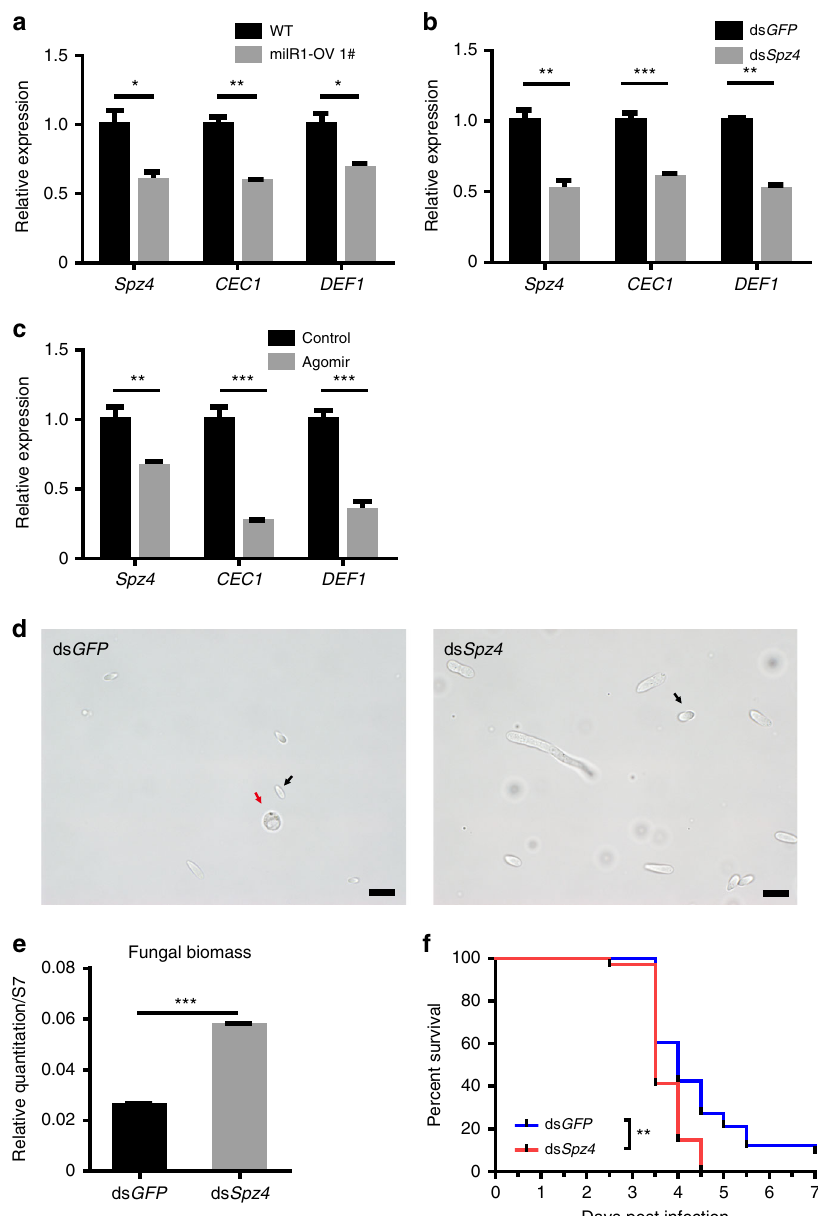
Fig. 4 bba-milR1 attenuates host immunity by suppressing Toll receptor ligand Spätzle 4. a The relative transcript levels of Spz4 , cecropin 1 ( CEC1 ), and defensin 1 ( DEF1 ) in mosquitoes at 48 h post infection (hpi) with WT and bba-milR1-overexpressing strain milR1-OV 1#. The expression values are normalized to WT. b Effect of Spz4 silencing on the expression of CEC1 and DEF1 . The expression values are normalized to dsGFP. c The relative transcript levels of Spz4 , CEC1 , and DEF1 in the mosquitoes injected with bba-milR1 agomir (200 nM) or control agomir (200 nM). The expression values are normalized to control. d Effect of Spz4 silencing on fungal hyphal body formation in the mosquito hemocoel at 60 hpi. Black arrows point to hyphal bodies, and the red arrow points to a mosquito hemocyte. Scale bars, 10 μ m. e qPCR-based quanti fi cation of fungal load in mosquitoes injected with dsGFP or dsSpz4 at 60 hpi. Fungal levels are expressed as that of fungal 18S rRNA relative to A. stephensi ribosomal protein S7 (AsS7) DNA. f Effect of Spz4 silencing on the survival of mosquitoes following topical application of a suspension of 10 7 conidia/ml of B. bassiana ARSEF252 (Log-rank test). Values are mean ± s.e.m. The experiments were repeated three times with similar results. * P < 0.05, ** P < 0.01, *** P < 0.001. P- value < 0.05 was regarded as